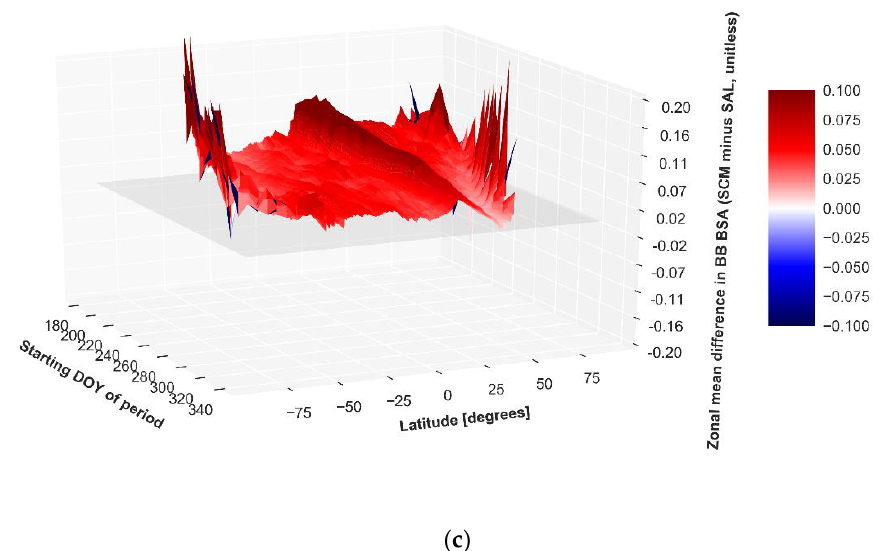
Figure 6. As Figure 5, but compared against CLARA-A2-SAL broadband BSA for ( a ) SCM DOY 180 – 190 versus CLARA-A2-SAL of the same period, ( b ) the SCM DOY 340 – 350 versus CLARA-A2-SAL of the same period, and ( c ) the time-latitude 3D representation of their difference in zonal means across the analyzed six months of SCM data in 2010. The zonal means calculated from grid cells where both SCM and CLARA have valid retrieved albedo. The maroon color indicates the overlap of SCM and CLARA albedo standard deviation within a 0.1-degree latitude band. The dashed line in subplots (a) and (b) indicate the number of valid grid cells for the calculation of each zonal mean. (secondary y-axis) Finally, we compared the retrieved BSA from the SCM demonstrator and from the resampled MCD43D as a function of land cover through the full sampling period. The ESA GlobCover dataset [60] was first reprojected into the SCM grid, selecting the majority land cover of the GlobCover data within each 0.1 degrees by 0.1 degrees grid cell to represent the land cover type corresponding to each SCM grid cell. The BSA differences across all SCM sampling periods were then aggregated into the land cover types; the following results are shown in Figure 7.